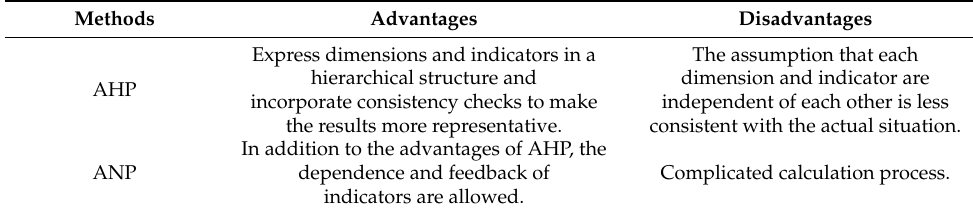
Table 1. Advantages and disadvantages comparison table of AHP and ANP methods.